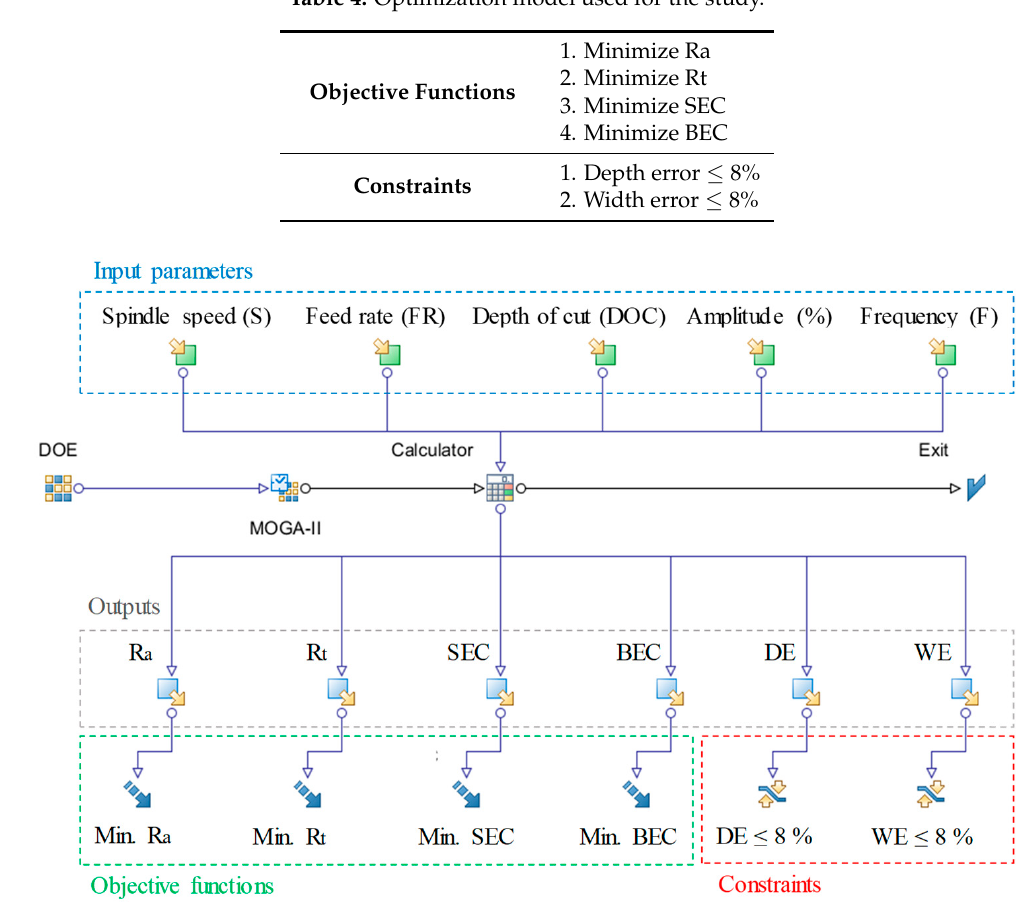
Figure 16. Tool wear: ( a ) a 3D view of the used RUM tool; ( b ) end cutting face of the new RUM tool; ( c ) end cutting face of the used RUM tool; ( d ) end face profile of the new tool; ( e ) end face profile of the used tool; ( f ) side face profile of the new tool; and ( g ) side face profile of the used tool.